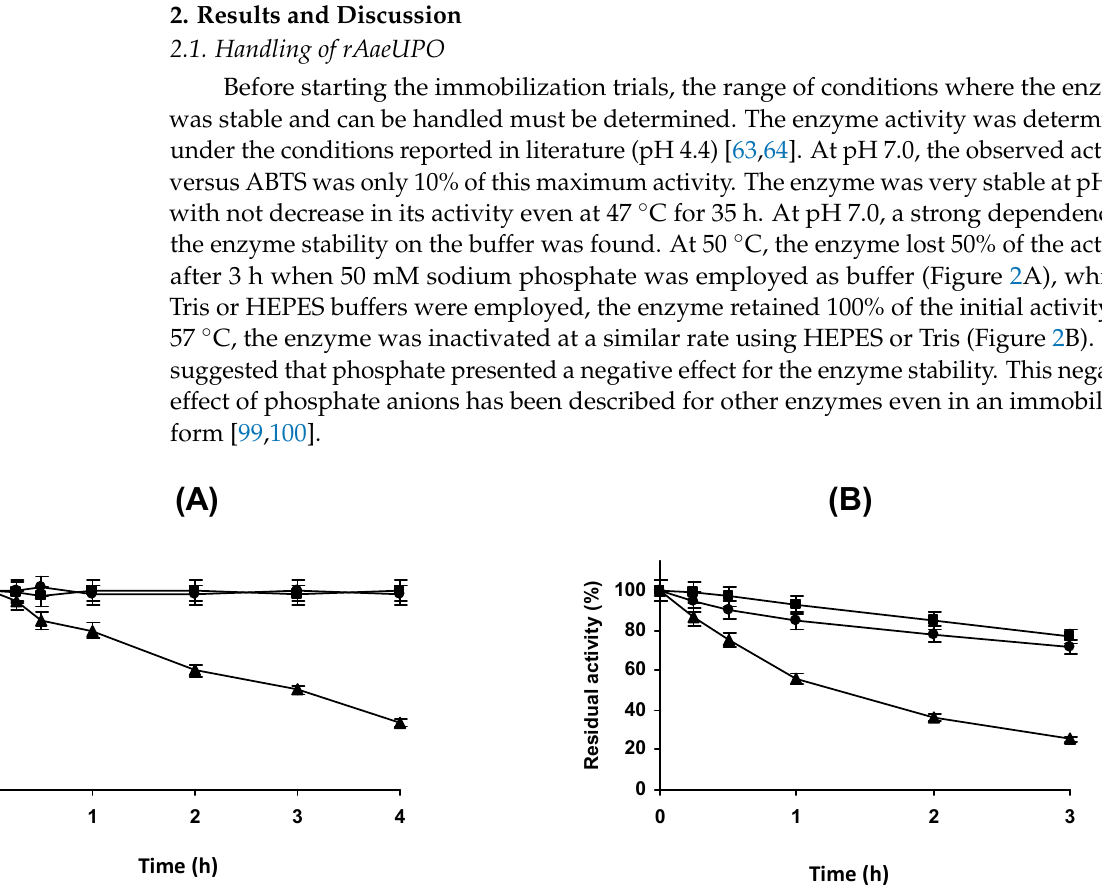
Figure 3. Effect of the concentration of free r Aae UPO stability. The experiments were performed at pH 7 ( A ) 50 mM sodium phosphate at 57.0 or ( B ) 50 mM Tris at 57.5 °C. Other specifications can be found in the Methods section. Full circles: dilution 1:250; full triangles: dilution 1:1000; empty squares: dilution 1:2000; full rhombus: dilution 1:4000; empty triangles: dilution 1:8000; empty circles: dilution 1:16,000. At pH 10.0 (pH necessary to immobilize the enzyme on glyoxyl-agarose beads) [40] and 25 °C, the enzyme was rapidly inactivated (residual activity was only 5% after 4 h), preventing immobilization of the enzyme under these conditions (Figure 4). The addition of glycerol to the medium significantly stabilized the enzyme, and this was more signifi- cant when the glycerol concentration increased (the enzyme retained over 60% of the ini- tial activity after 4 h in 40% glycerol) (Figure 4). This enzyme stabilizing effect of glycerol has been recently examined, and although it is not universal, it is a quite general phenom- enon [44]. At 4 °C and in 40% glycerol, the enzyme maintained around 75% of its activity after 4 h (Figure 4).